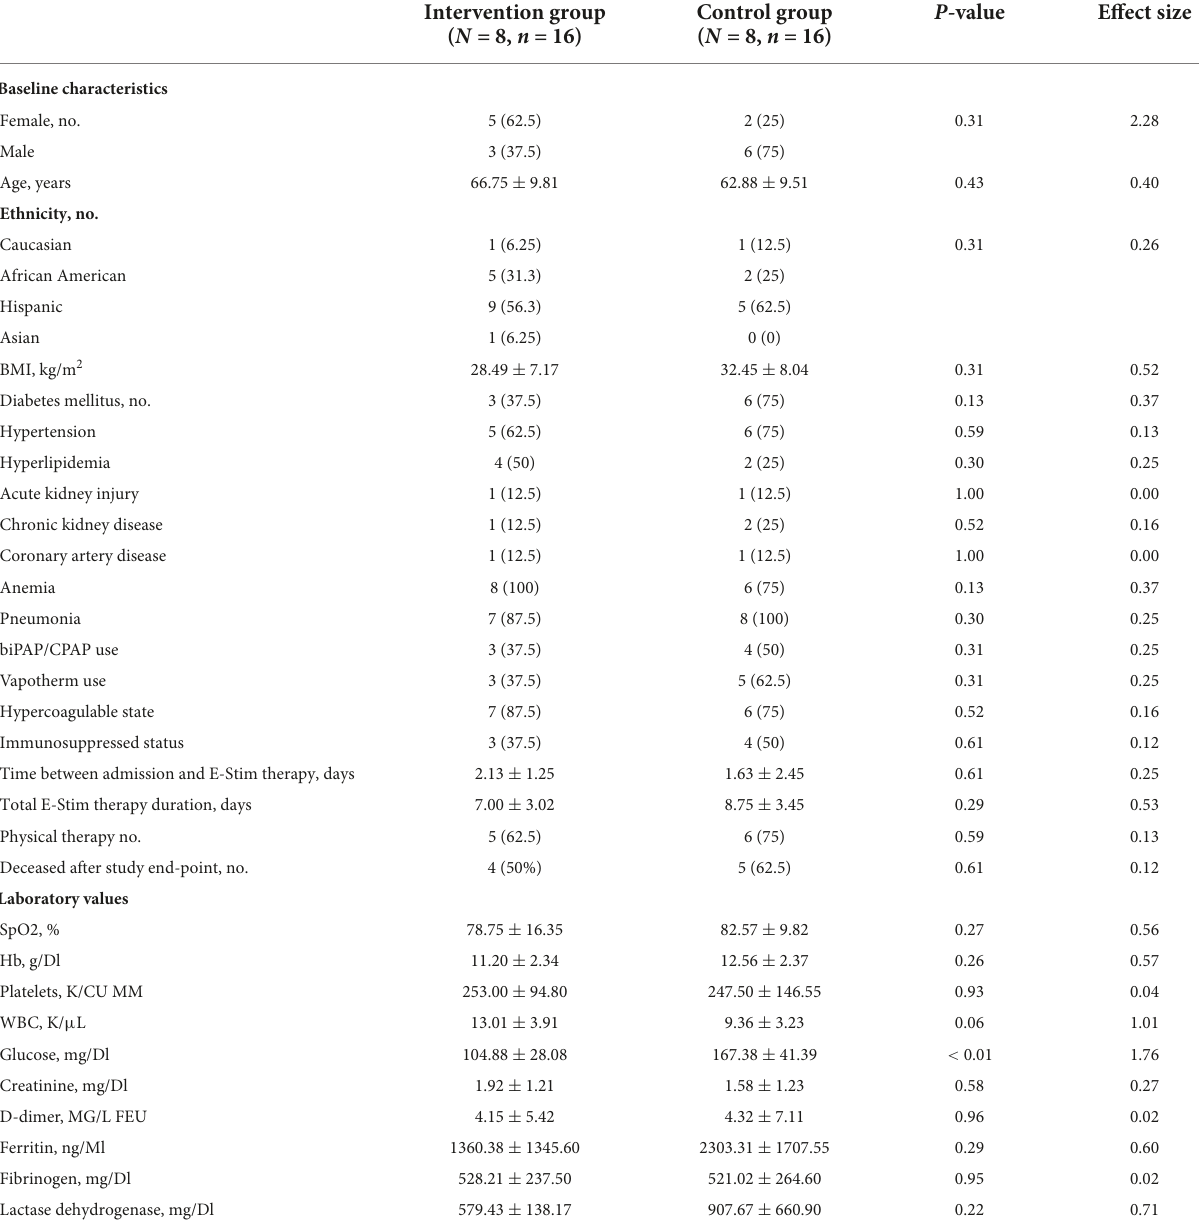
P -value Effect size